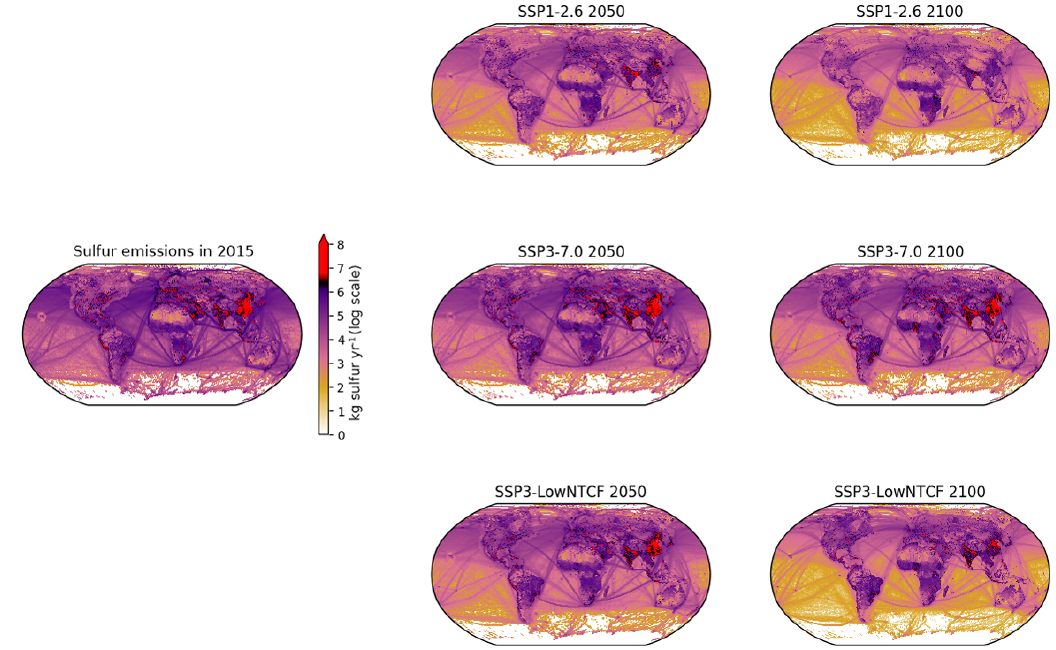
Figure 10. Downscaled and gridded emissions of sulfur at present and in 2050 and 2100 for SSP1-2.6, SSP3-7.0, and SSP3-LowNTCF.